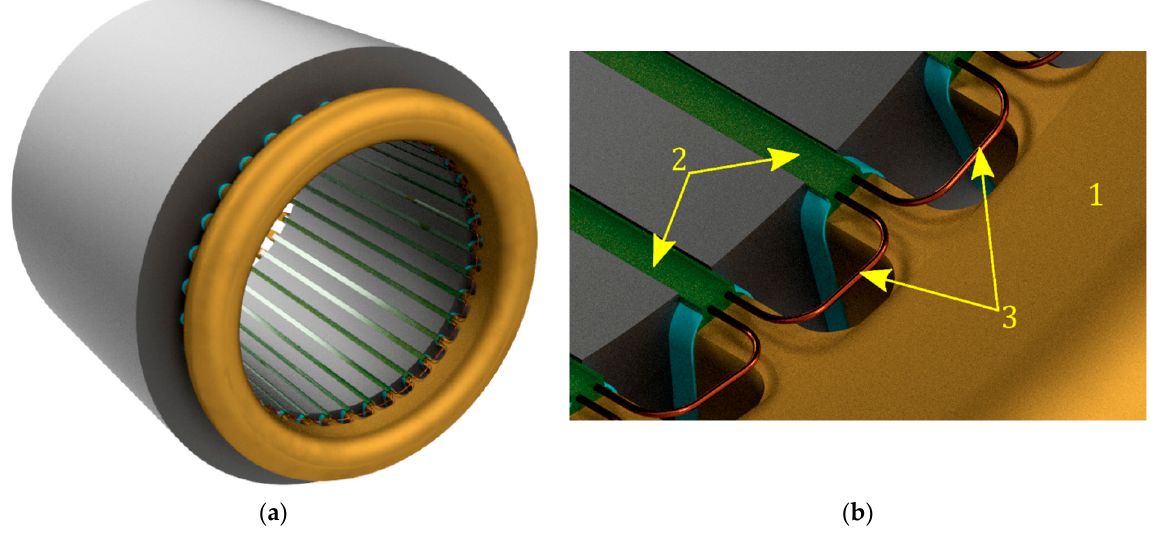
Figure 7. ( a ) Wound stator with a shielding winding placed in the slot wedges, ( b ) Fragment of the stator iron core with visible shielding winding connections; 1—stator end-winding, 2—slot wedges, 3—connections of shielding wires placed in wedges.